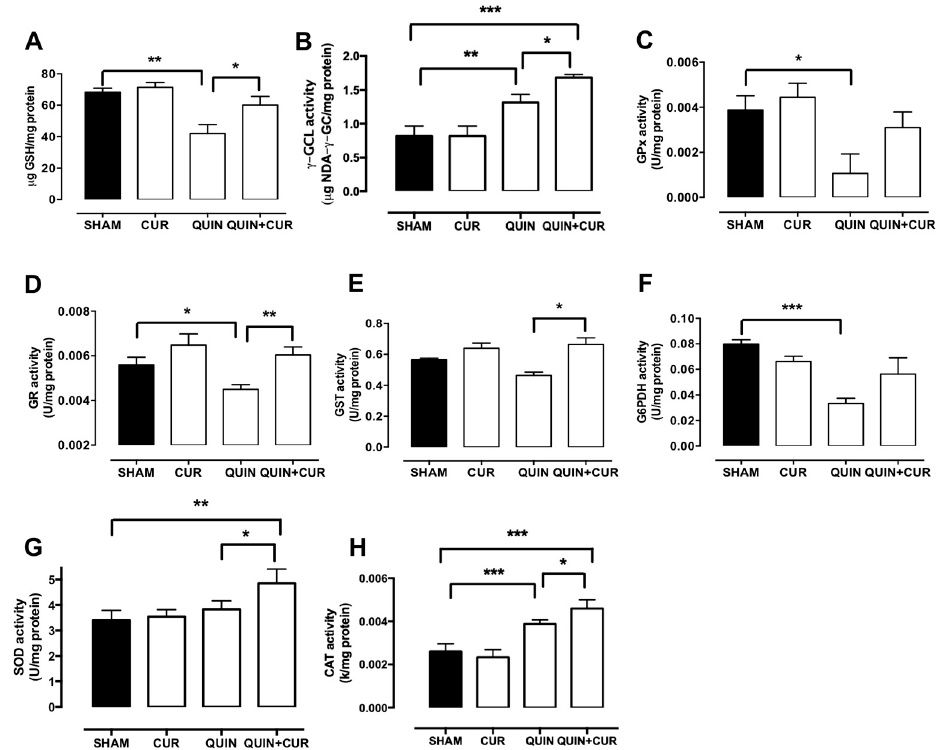
Figure 8. Effect of quinolinic acid (QUIN) and curcumin (CUR) on the glutathione (GSH) levels and enzymatic activity of proteins regulated by nuclear factor erythroid 2-related factor 2 (Nrf2). Assays were performed at 7 days after the QUIN injection. GSH levels ( A ) and enzyme activity of ( B ) γ -glutamylcysteine ligase ( γ -GCL), ( C ) glutathione peroxidase (GPx), ( D ) glutathione reductase (GR), ( E ) glutathione S-transferase (GST), ( F ) glucose 6 phosphate dehydrogenase (G6PDH), ( G ) superoxide dismutase (SOD), and ( H ) catalase (CAT) in the striatum are presented. Data are expressed as mean ± SEM (n = 5 for GPx, GR, GST, G6PDH, and GSH and n = 4 for γ -GCL, SOD, and CAT). * p < 0.05, ** p < 0.01, and *** p < 0.001.